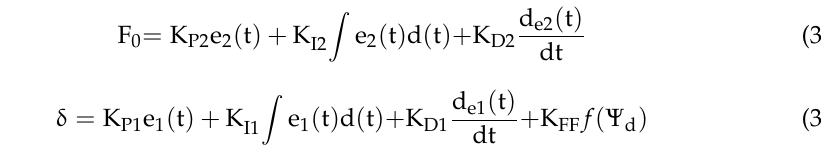
Figure 9. Control scheme employed on the proposed USV.